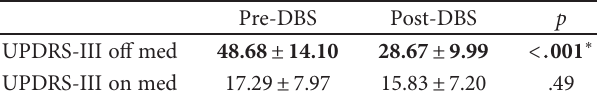
Table 4: Apathy and mood ratings pre- and post-DBS.